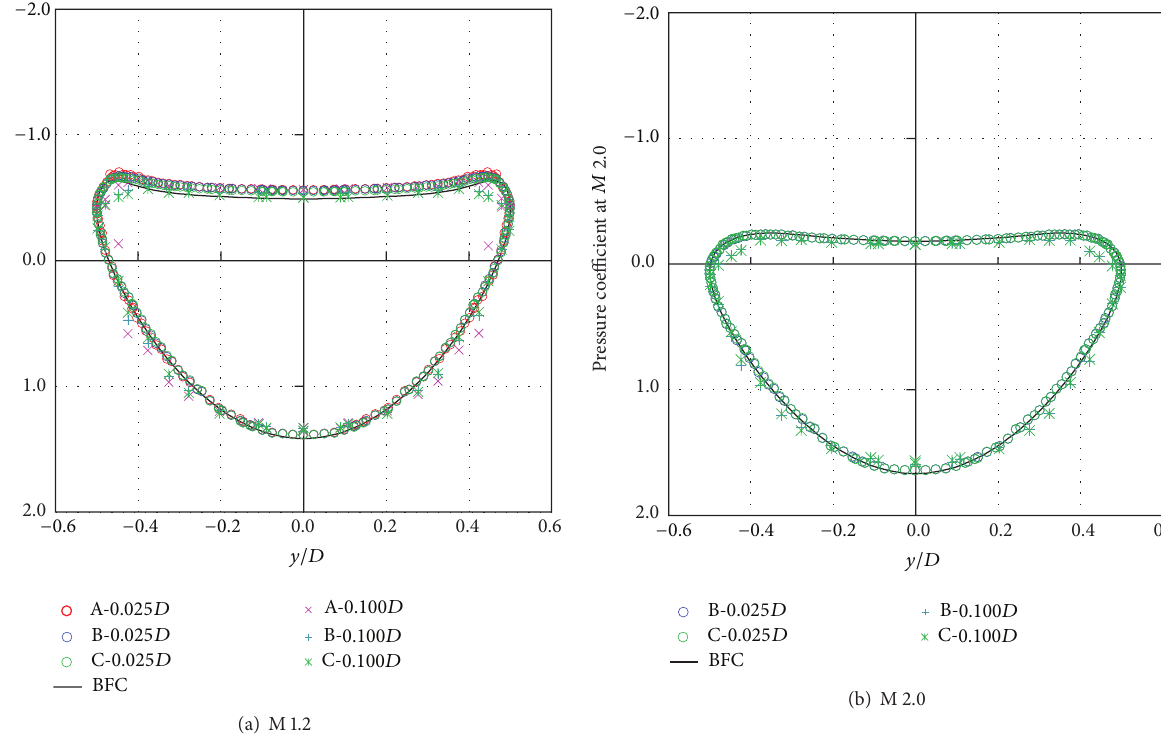
Figure 18: Surface pressure coefficient distributions at M 1.2 and M